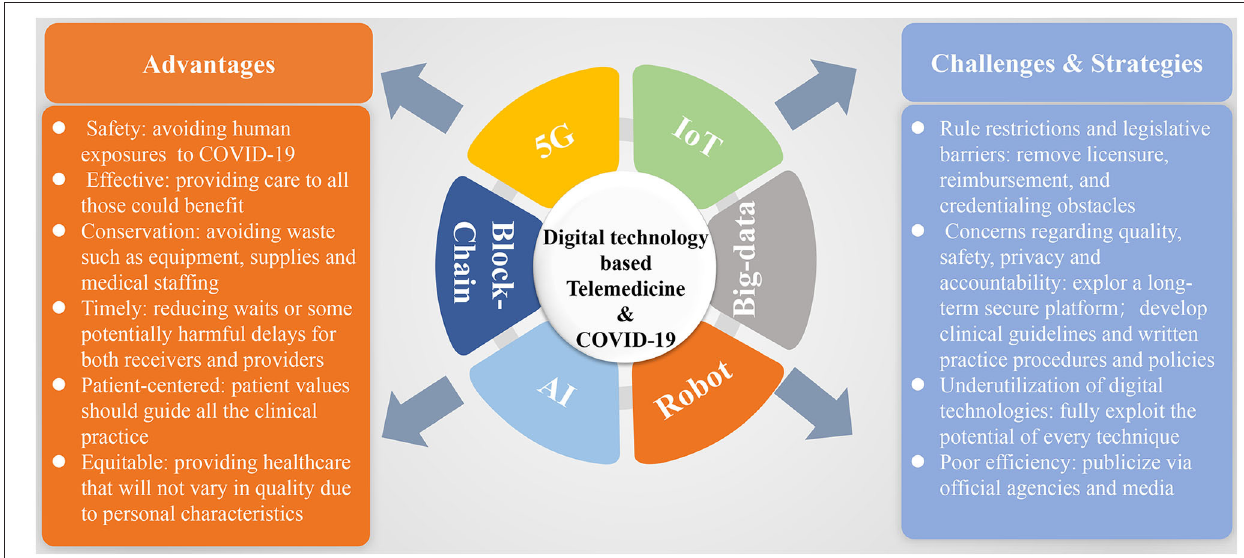
FIGURE 8 | Summative scheme of digital technology-based telemedicine used during the COVID-19 outbreak with its advantages, challenges, and strategies for future wide application. COVID-19, coronavirus disease 2019; 5G, fifth generation; IoT, internet of things; AI, artificial intelligence.